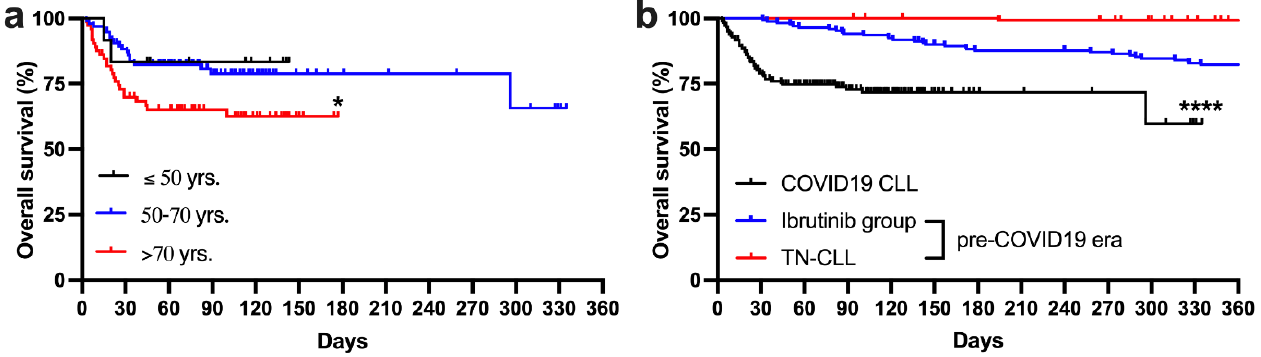
Figure 2. Kaplan–Meier survival curves of the whole cohort in particular age groups ( a ) and in comparison to treatment-naïve chronic lymphocytic leukemia patients (TN–CLL) and observational relapse and refractory chronic lymphocytic leukemia treated with ibrutinib (ibrutinib group) patients form the pre-COVID-19 time ( b ). Data were cut to 360 days on the time axis. * p < 0.05; **** p < 0.0001 (Log-rank test) .